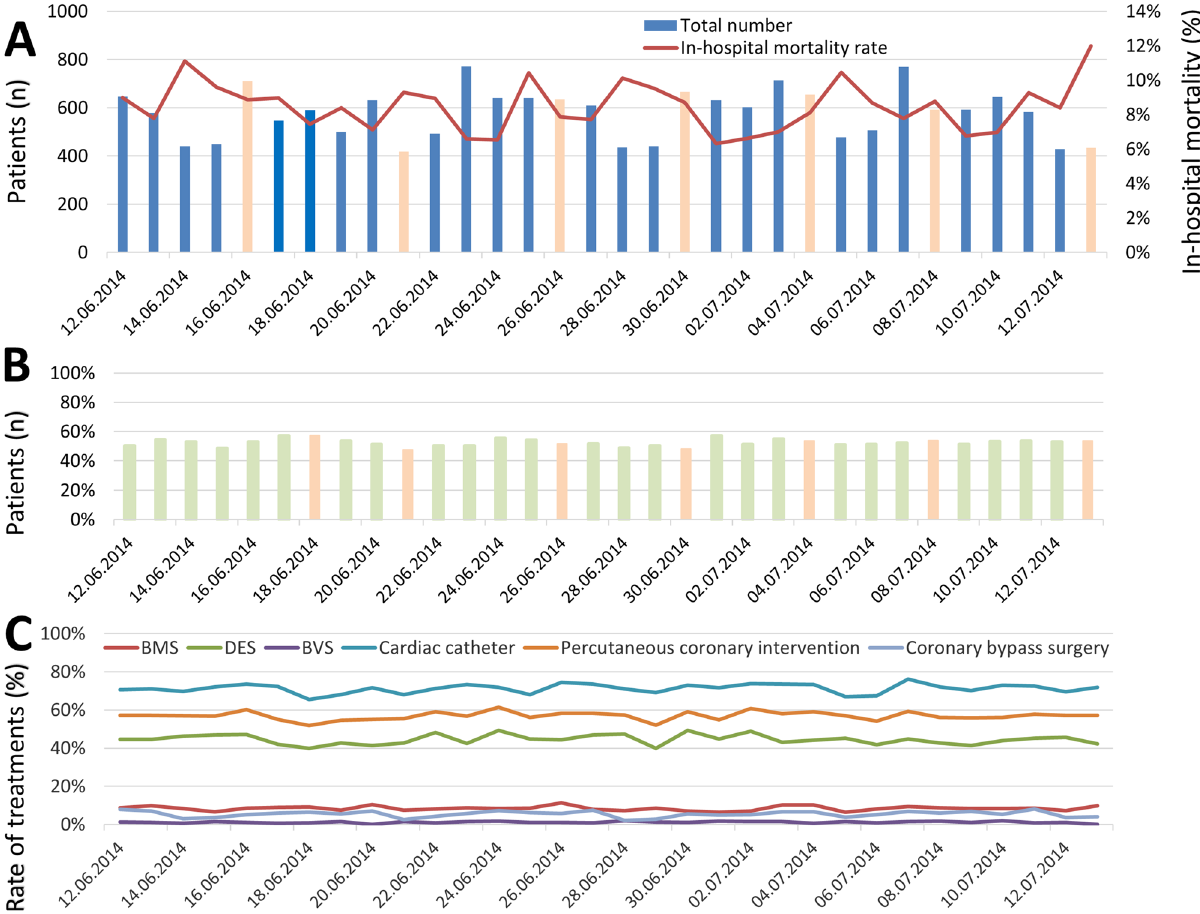
Figure 2. Temporal trends. ( A ) Absolute numbers of patients admitted due to MI events (bars) and in-hospital mortality rate (red line) across the soccer world cup 2014. The match days of German national team were colored in orange (16th June 2014 Germany vs. Portugal 4:0; 21st June 2014 Germany vs. Ghana 2:2; 26th June 2014 USA vs. Germany 0:1; round of 16: 30th June 2014 Germany vs. Algeria 2:1; quarterfinal: 04th July 2014 France vs. Germany 0:1; semifinal: 8th July 2014 Brazil vs. Germany 1:7; final: 13th July 2014 Germany vs. Argentina 1:0) and those days without German team-participation in blue. ( B ) Proportion of MI events in patients ≥ 70 years (green bars). ( C ) Proportion of MI events with different interventional and surgical treatments during the world cup 2014 (red line: bare metal stent (BMS) implantation; light green line: drug eluting stent (DES) implantation; violet line: bioresorbable vascular scaffolds (BVS) implantation; light blue line: cardiac catheter; orange line: percutaneous coronary intervention (PCI); dark blue line: coronary bypass